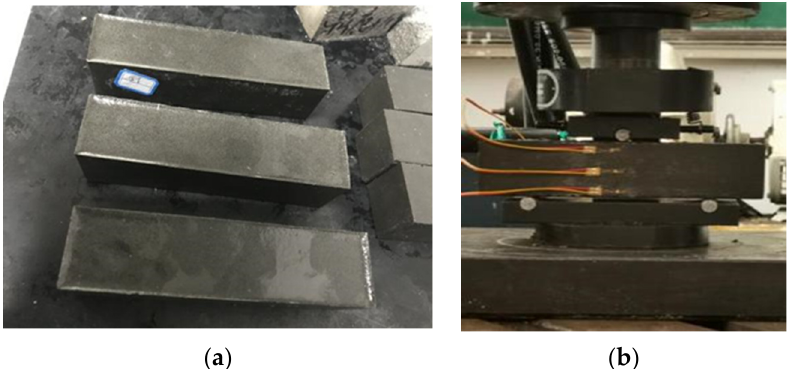
Figure 4. Prism specimen of flexural tensile strength test and the test process. ( a ) Test specimen; ( b )Test process